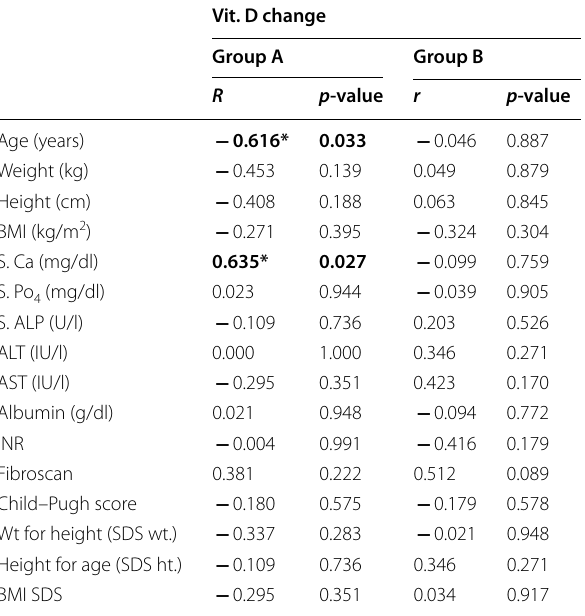
Table 9 Correlation between vitamin D level changes after supplementation in relation to anthropometric measures, metabolic profile and fibroscan